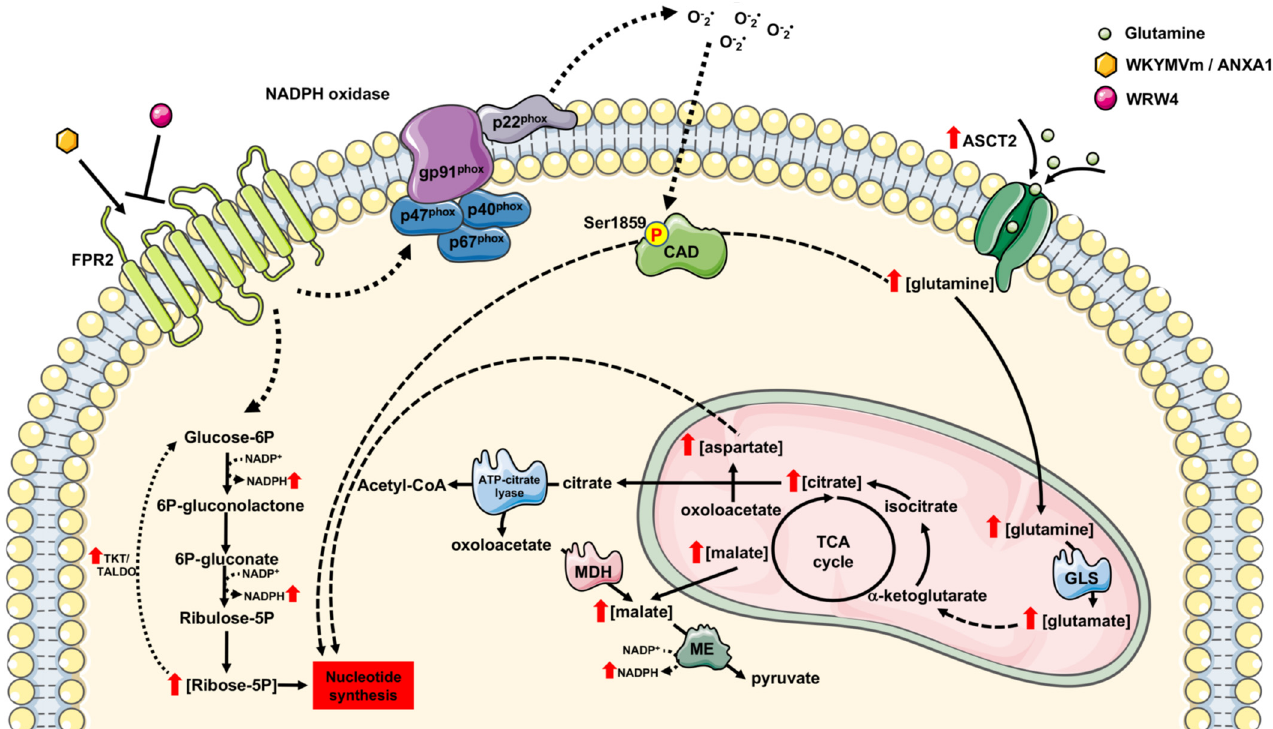
Figure 8. FPR2 signaling triggers metabolic reprogramming of lung cancer cells. FPR2 stimulation increases the ribose 5-phosphate (Ribose-5P) concentration and stim-ulates the pentose phosphate pathway (PPP), thus promoting NADPH generation. WKYMVm and ANXA1 binding to FPR2 also induce enhanced transketolase (TKT) ac-tivity in the non-oxidative phase of the PPP and increases in the citrate and malate concentrations. In the cytosol, citrate can be converted in acetyl-CoA and oxaloacetate, and the latter can be converted into malate through malate dehydrogenase (MDH). Malate may contribute to NADPH generation through a reaction catalyzed by the malic enzyme (ME). FPR2 signaling induces an increase in the expression of the gluta-mine transporter ASCT2 and enhances the concentration of aspartate and glutamine, the pyrimidine nucleotide biosynthesis precursors. CAD, the multifunctional enzyme that participates in the three initial speed-limiting steps of de novo pyrimidine nucleo-tide synthesis, is phosphorylated at the Ser1859 residue in a NADPH oxidase-dependent manner upon the binding of WKYMVm and ANXA1 to the receptor. Therefore, the FPR2-mediated activation of CAD and enhanced concentrations of Ribose-5P, aspar- tate, and glutamine contribute to an increased de novo biosynthesis of nucleotides. Glutamine can be converted into glutamate by glutaminase (GLS). Glutamate can be converted into oxoalacetate and fuel the tricarboxylic acid cycle (TCA) that, in turn, increases the mitochondrial membrane potential. ME: Malic enzyme; MDH: Malate dehydrogenase; TKT: Transketolase; TALD: Transaldolase; GLS: Glutaminase; CAD: Carbamoyl-phosphate synthetase 2, aspartate transcarbamoylase, and dihydroorotase; Glucose-6P: Glucose 6 phosphate; 6P-gluconolactone: 6 phospho-gluconolactone; 6P- gluconate: 6-phospho-gluconate; Ribulose-5P: Ribulose 5-Phosphate; Ribose-5P: Ri-bose